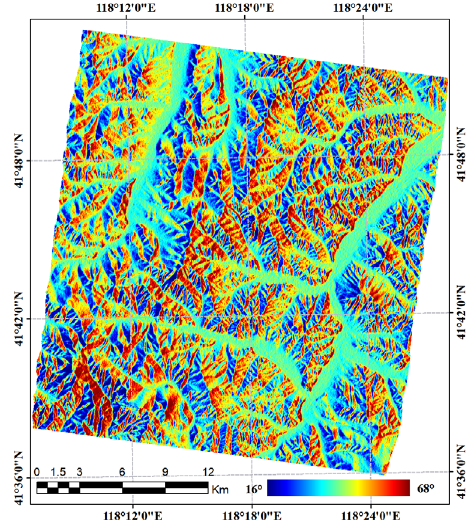
Figure 6. Projection angle ( ψ ).